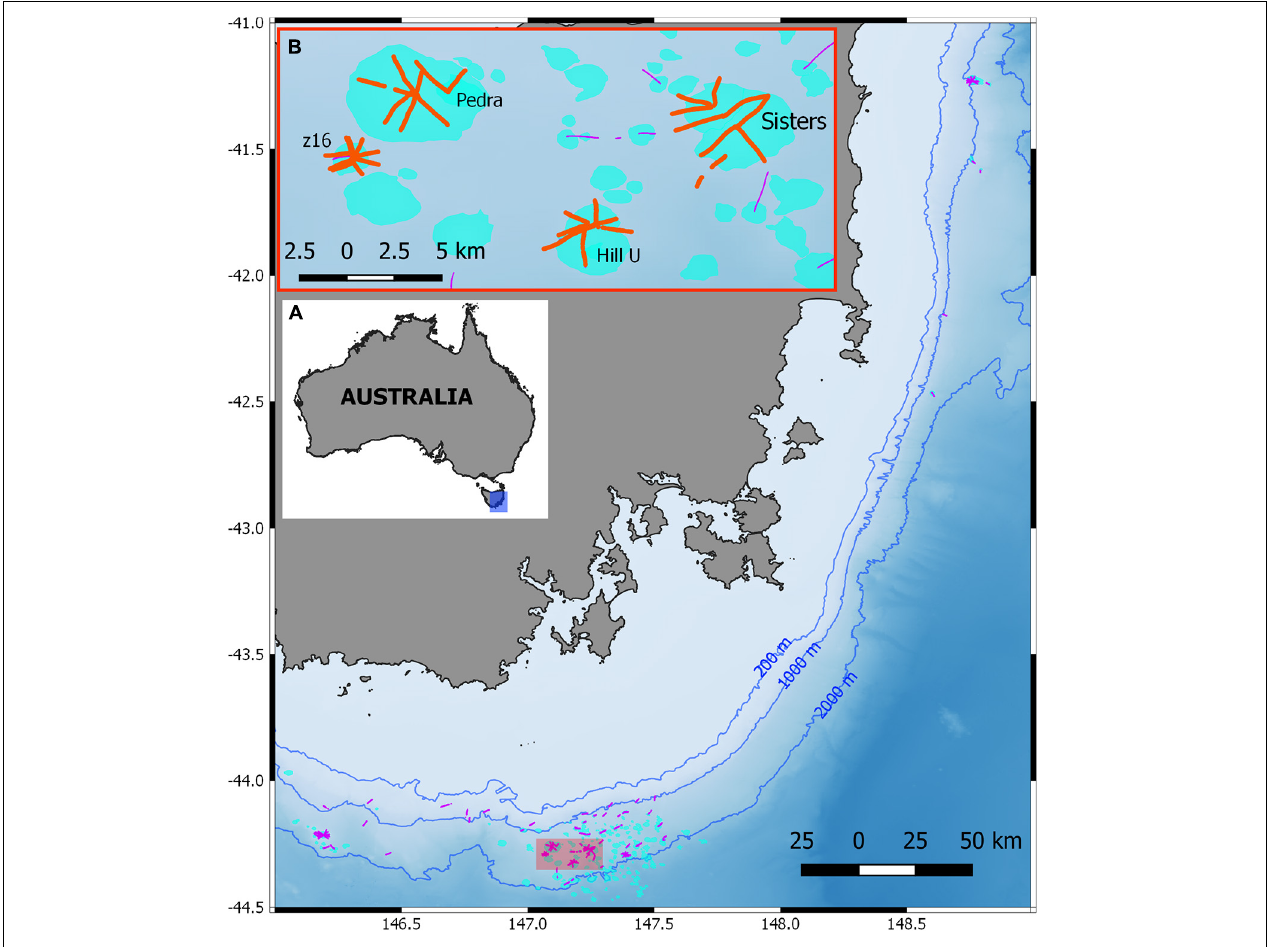
FIGURE 1 | (A) Overview map of the Tasmanian seamounts region showing seamounts (light blue) and image transects (black lines). Background shading shows depth range, with major contours indicated. (B) Inset shows seamounts selected for the case study analysis showing image transects (orange lines) included in this